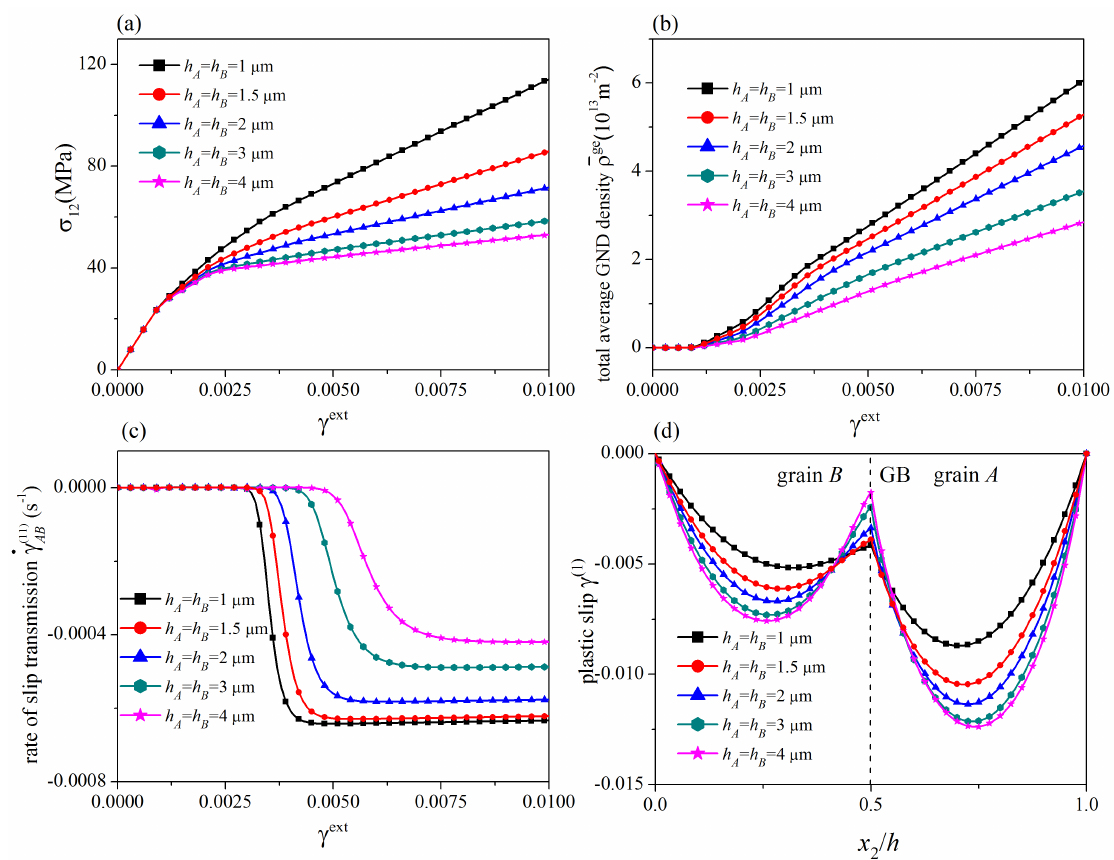
Figure 5. Size effects: ( a ) stress-strain curves; ( b ) total average GND density; ( c ) the rate of